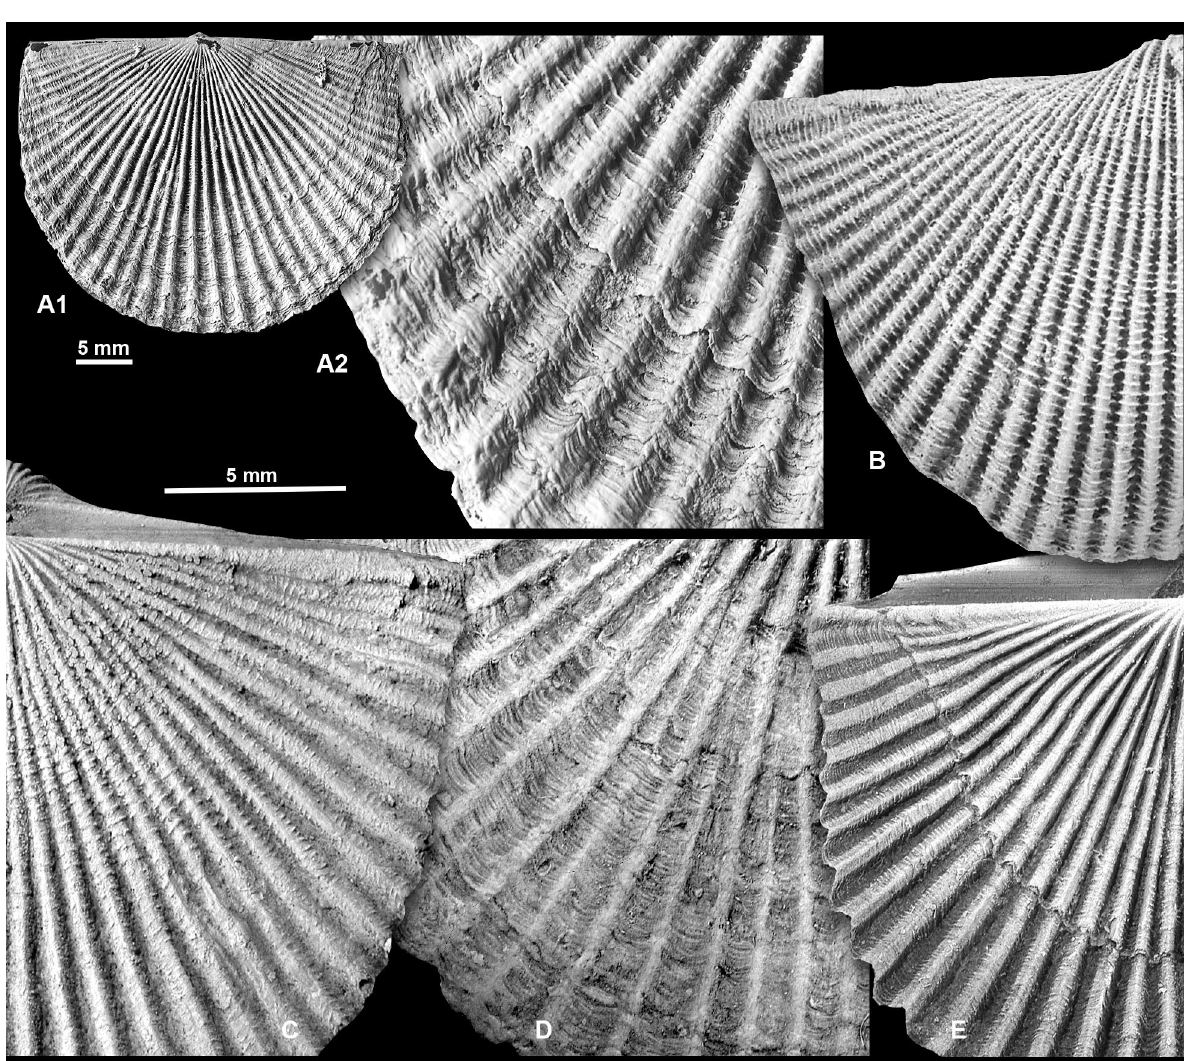
Fig. 5. Exterior sculpture. A1 , A2 , Cyrtonotella kuckersiana kuckersiana (Wysogórski, 1900), dorsal valve TUG 1054-18 (Br 075). B , Cyrtonotella kuckersiana frechi (Wysogórski, 1900), shell GIT 400-40, filate ribbing on ventral valve. C , Cyrtonotella kuckersiana frechi (Wysogórski, 1900), holotype, shell GIT 400-70, filate ribbing on dorsal valve. D , Cyrtonotella barbara (Öpik, 1930a), holotype, shell TUG 1054-24 (Br 084), exterior sculpture on dorsal valve. E , Cyrtonotella laine (Öpik, 1930a), shell GIT 400-47, exterior sculpture on dorsal valve. Scale 5 mm for A1, 5 mm for